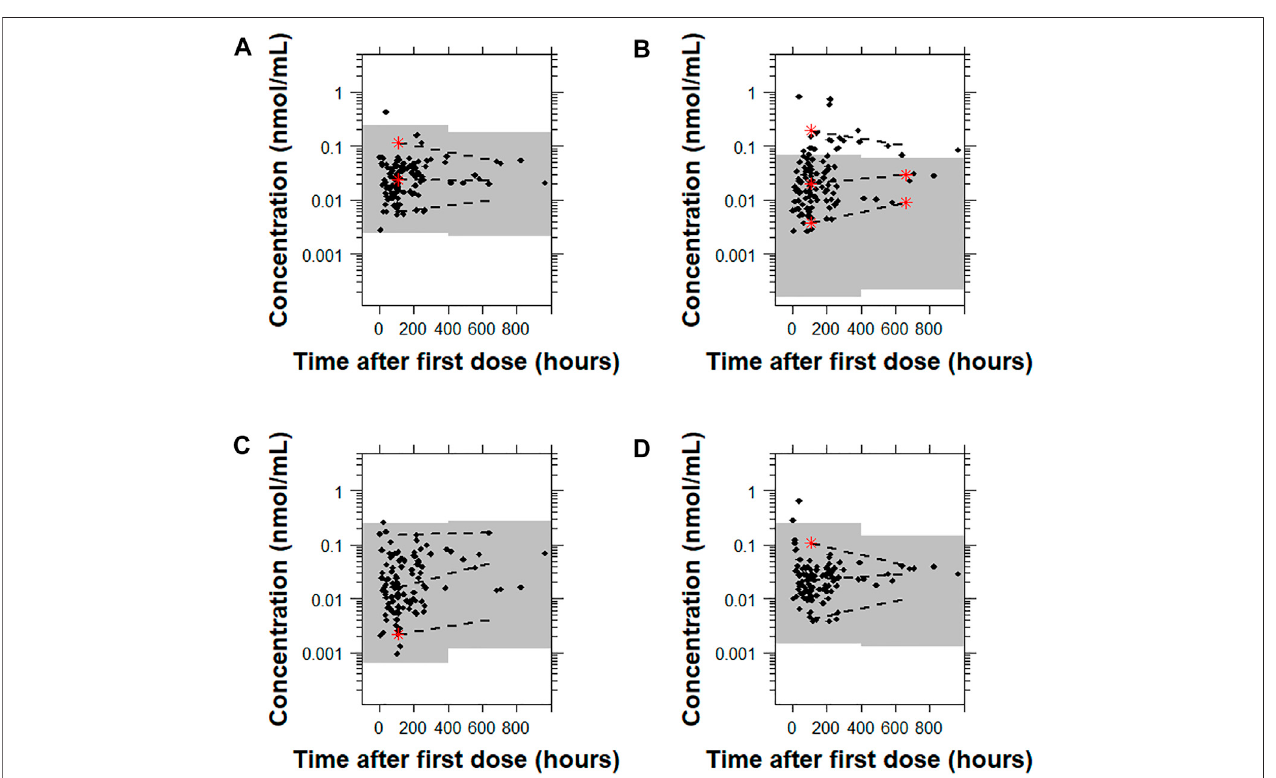
FIGURE 7 | Prediction-corrected visual predictive checks (pcVPCs) where the observed data are overlaid on the predictions obtained by performing 1,000 simulations with each model for 9-OH risperidone. Model (A) : Kloosterboer et al., 2021; Model (B) : Sherwin et al., 2012; Model (C) : Feng et al., 2008; and Model (D) : Feng et al., 2008 with allometric scaling. All pcVPC plots are based on the time after the fi rst dose. The dashed lines are the 5th, 50th, and 95th percentiles for the observeddata,andthegrayshadedregionsrepresentthe95%predictionintervalforthepredictedconcentrations.Theredstarsindicateoutlyingpercentilesofthe observeddata from theprediction interval. The x axis representsthetimeafter fi rst recorded dose. Asamplethat wascollected later than1,000 h after the fi rstrecorded dose was omitted from the graphs to improve visualization. The point was within the prediction interval for all of the models tested.